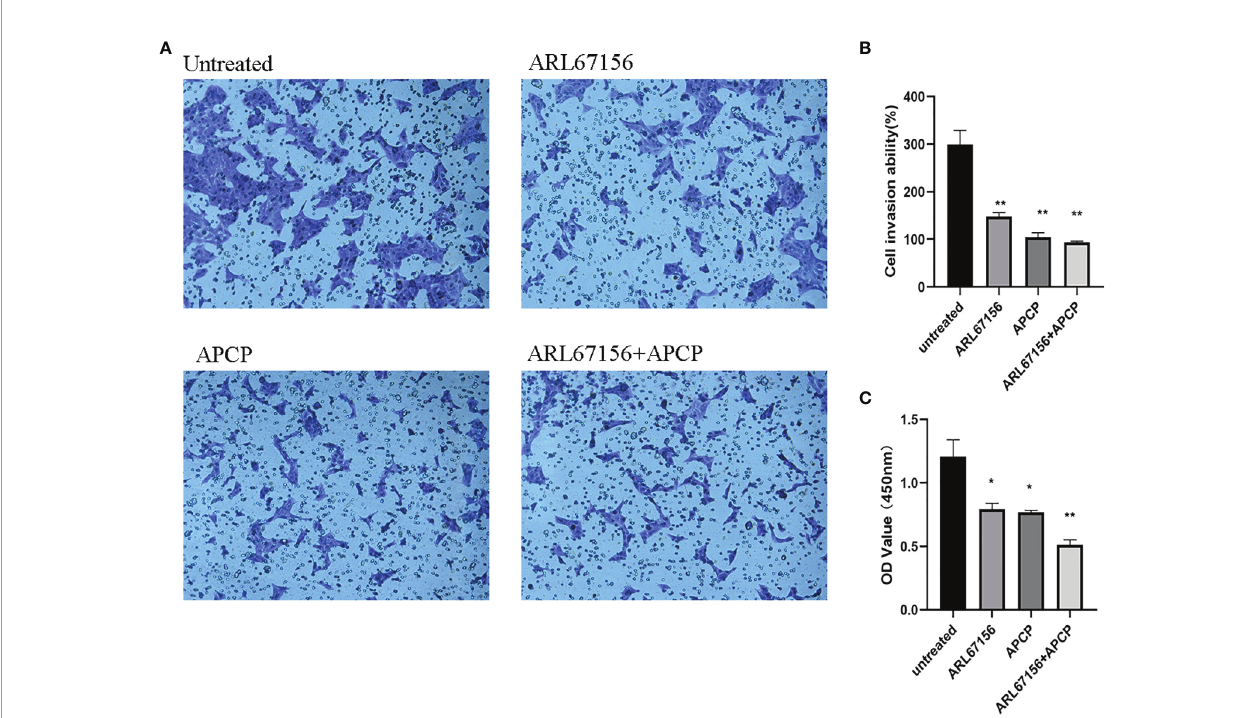
FIGURE 6 | The change of invasion and proliferation of HTR8/SVneo cells after inhibiting CD39 and CD73. Representative photos (A) and data (B) for the matrigel transwell assay of normal dNK cells from healthy donors co-cultured with the HTR-8/SVneo cells (dNK: HTR-8/SVneo cells = 2:1) in the absence or presence of the CD39 inhibitor ARL67156 and/or the CD73 inhibitor APCP. n = 3 for each group (mean ± SEM, **P < 0.01 compared with the untreated group, one-way ANOVA and post hoc tests). (C) The OD values of the HTR-8/SVneo cells in the CCK-8 assay, showing their proliferation capacities (mean ± SEM, *P < 0.05, **P < 0.01 compared with the untreated group, one-way ANOVA and post hoc